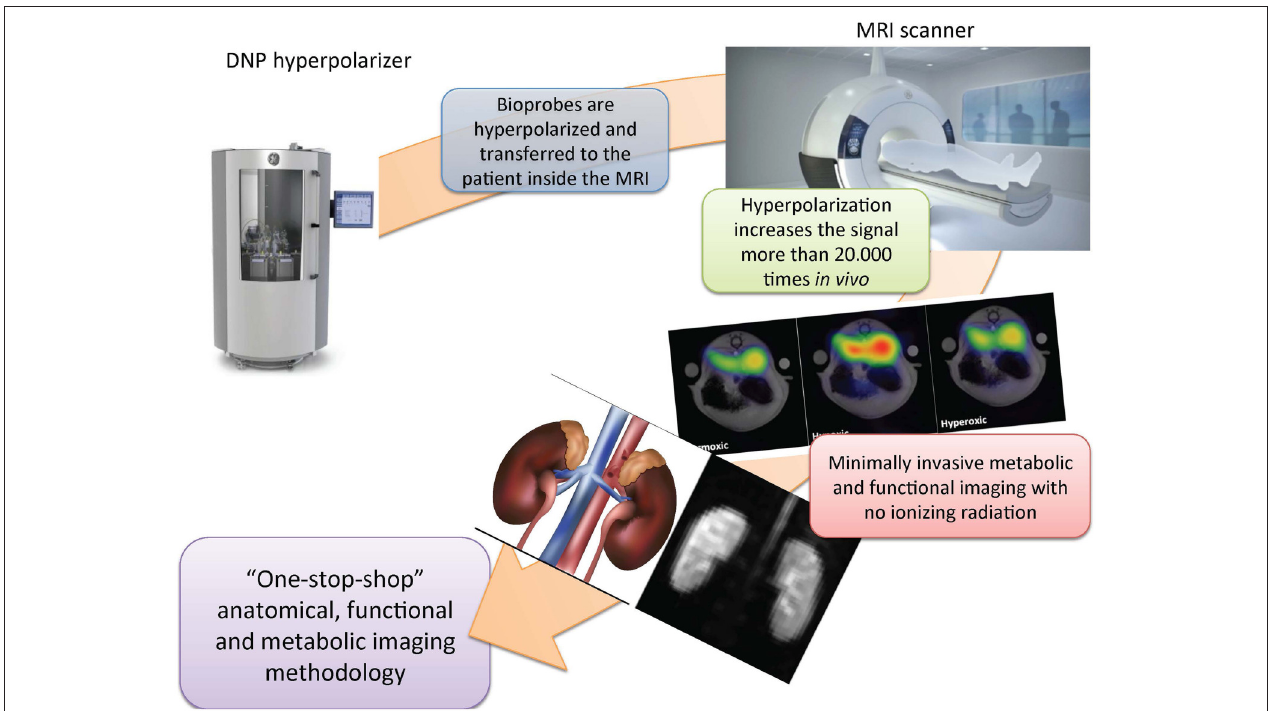
FIGURE 1 | Dissolution dynamic nuclear polarization magnetic resonance imaging—a “one-stop-shop” methodology. The biomarker is hyperpolarized and transferred by intravenous injection to the patient inside the clinical scanner. This procedure increases the sensitivity of the measurements by more than 20,000 times, and enables the direct interrogation of renal uptake and metabolic turnover. Standard clinical magnetic resonance imaging (MRI) capabilities are simultaneously available and provide a very versatile and sensitive diagnostic modality that is free of ionizing radiation and thereby ensures patient safety. DNP, dissolution dynamic nuclear